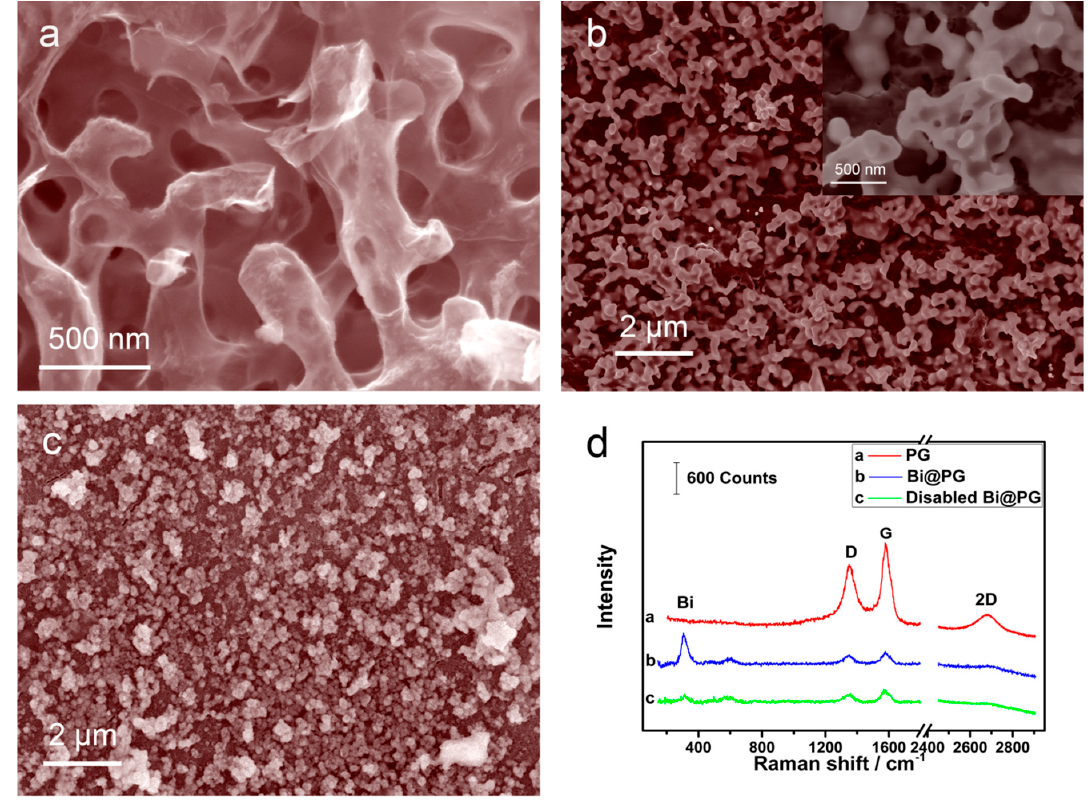
Figure 1. SEM images of ( a ) porous graphene (PG), ( b ) Bi@PG and ( c ) disabled Bi@PG; ( d ) Raman spectra of PG, Bi@PG, and disabled Bi@PG; the wavelength of excitation of the laser is 532 nm and the power is 10 mW.